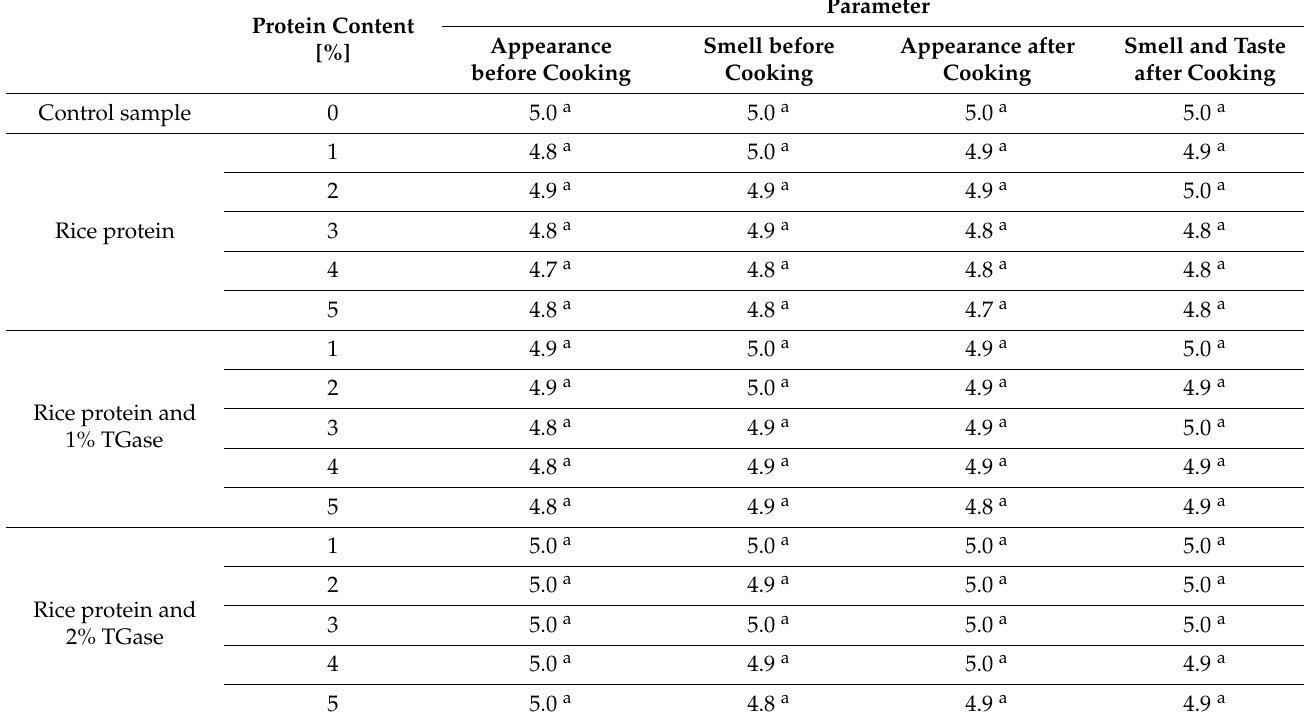
Table 3. Average values of the results of the sensory analysis of instant noodles with the additions of rice protein, rice protein and TGase. Mean values denoted by different letters ( a ) represent statistically significant differences between variables ( p < 0.05).